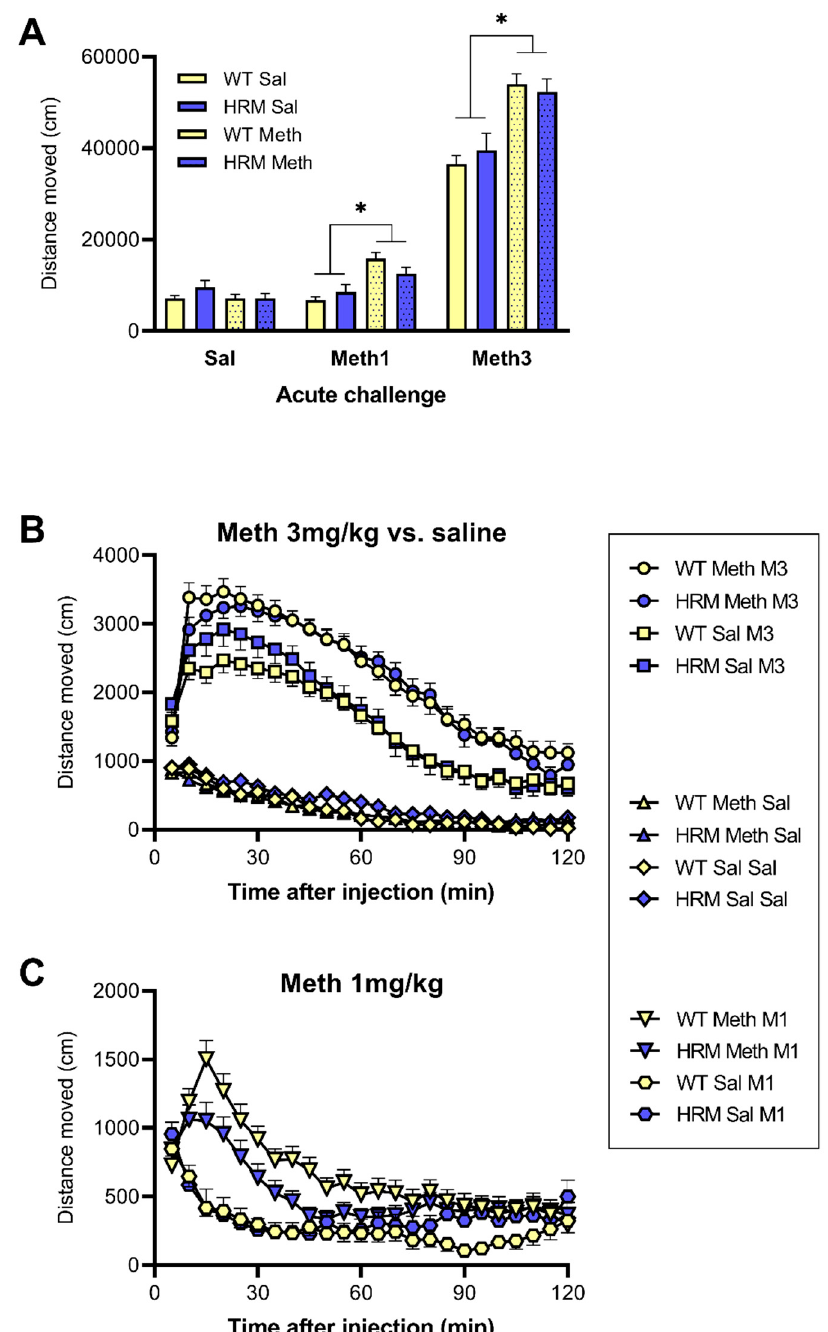
Figure 2. The e ff ect of acute challenge with saline, 1 mg / kg of Meth (Meth1) or 3 mg / kg of Meth (Meth3) on locomotor activity, expressed as distance moved. Panel A shows total distance moved over the 2 h post-injection period. * p < 0.05 for di ff erence between Meth-pretreated and saline-pretreated mice independent of genotype. Panel B shows locomotor hyperactivity every 5 min following acute injection of 3 mg / kg of Meth or saline. Meth-pretreated mice shows significantly greater Meth-induced hyperactivity than saline-pretreated mice but there were no significant genotype e ff ects. There were no di ff erences between the groups following acute saline treatment. Panel C shows locomotor hyperactivity every 5 min following injection of 1 mg / kg of Meth. Meth-pretreated mice show significantly greater Meth-induced hyperactivity compared to saline-pretreated mice but the were no di ff erences between the genotypes (see text for details of statistical analysis. Data are mean ± SEM of males and females combined.